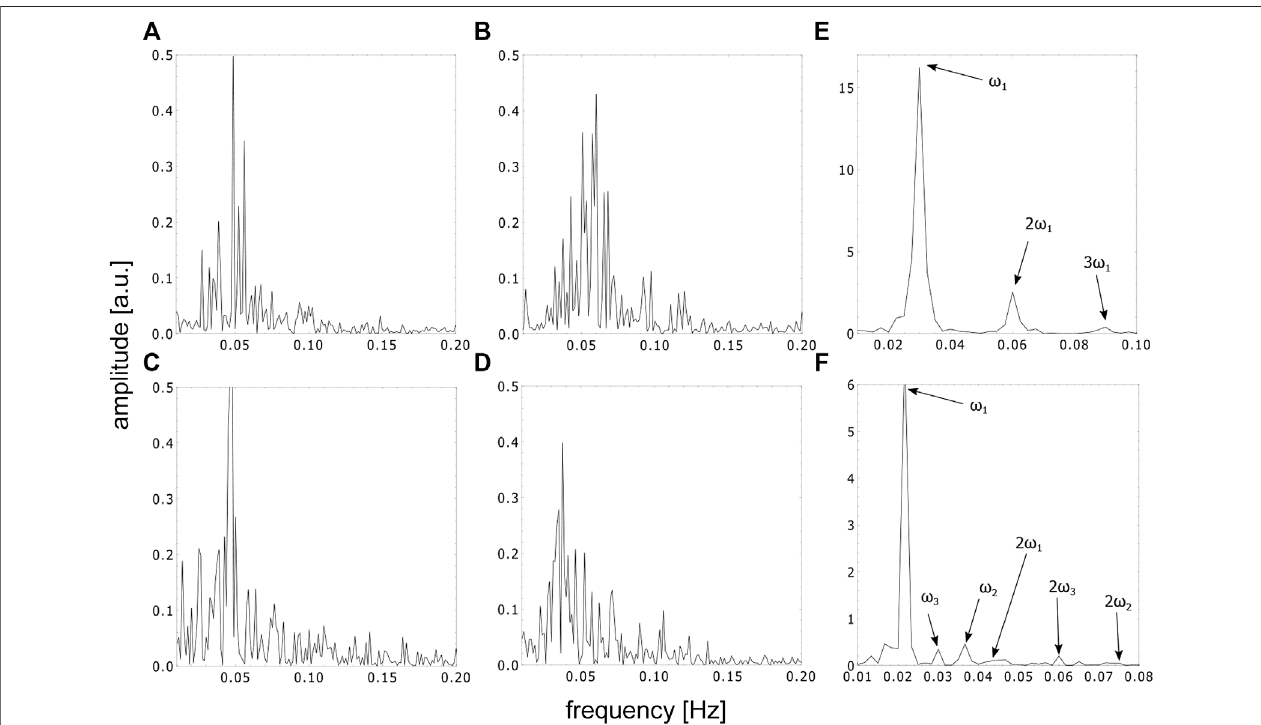
FIGURE 7 | FFT spectra of the time series in the special cuvette in different phases, (A – D) represent the FFT spectra of the time series in the aperiodic phase corresponding to the timeframes shown in Figures 4A – D , (E) represents the FFT spectra of the fi rst periodic and (F) represents the beginning of the second periodic phase,